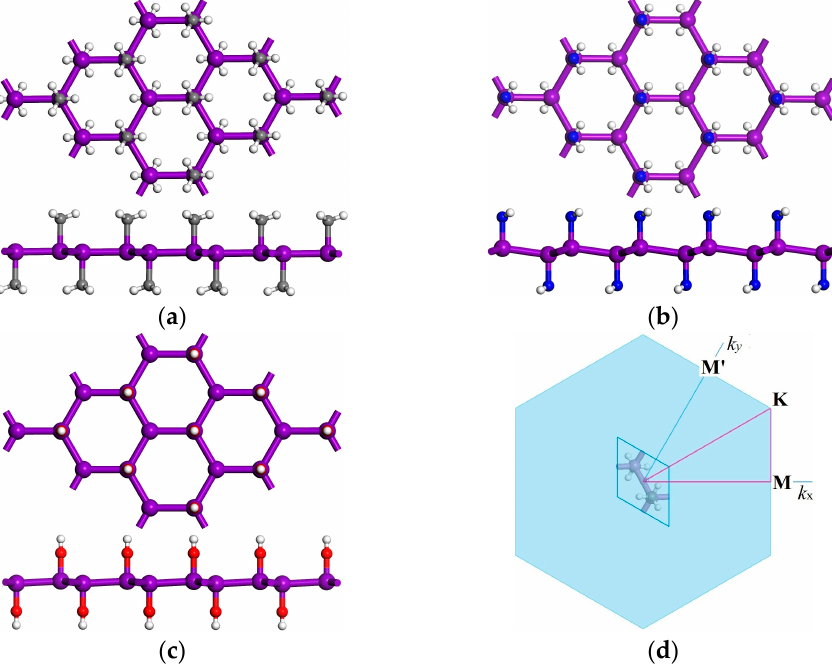
Figure 1. ( a – c ) Schematics of SbXH n and BiXH n monolayers decorated with methyl, amino, and hydroxyl groups, respectively, in which violet, gray, blue, red, and white balls symbolize the bonding atoms of Sb/Bi, carbon, nitrogen, oxygen, and hydrogen, respectively; ( d ) high symmetry points in the dispersion paths of electronic energy and phonon frequency in Brillouin zone.